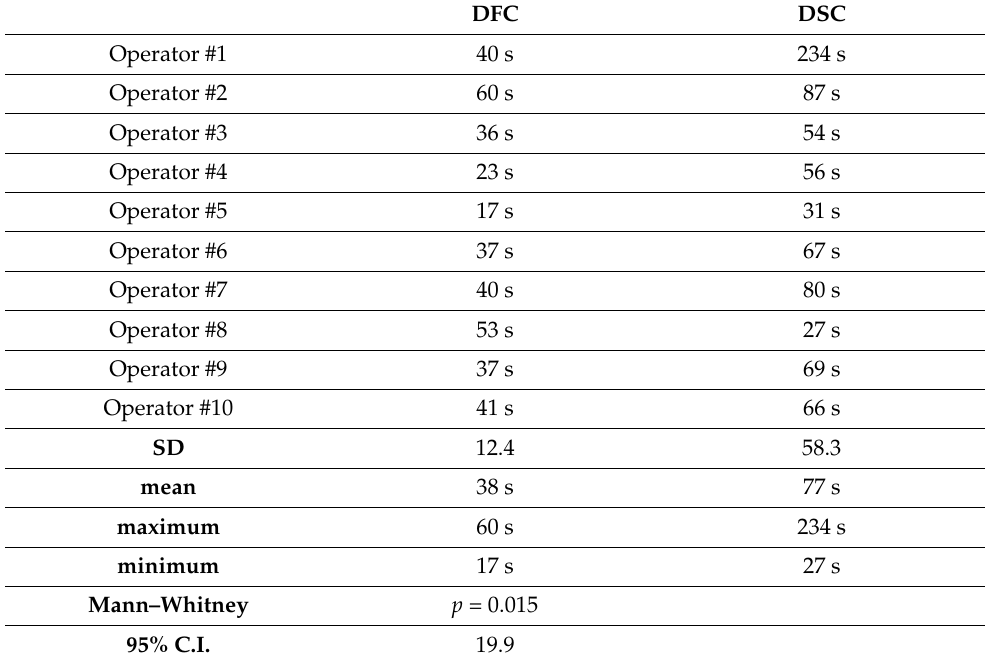
Table 1. Duration of de-bonding among similarly experienced operators and similar anatomy dental elements.